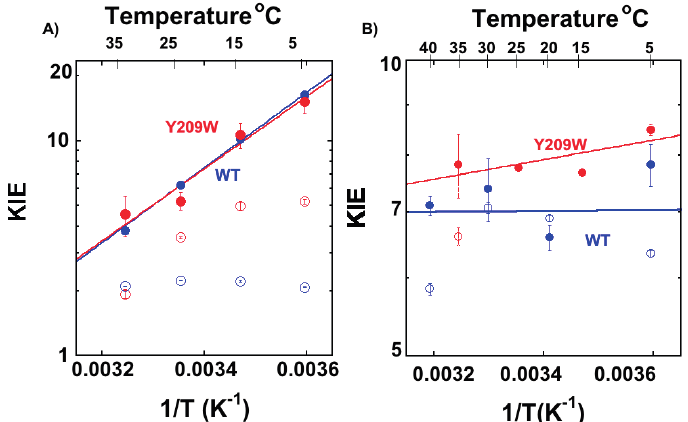
Figure 6. Arrhenius plots of the primary H/T KIEs on the proton abstraction ( A ) and the hydride transfer ( B ) catalyzed by the WT [16,25] (blue) and Y209W [15] (red). The empty circles represent the observed KIEs, and filled circles represent the intrinsic KIEs.